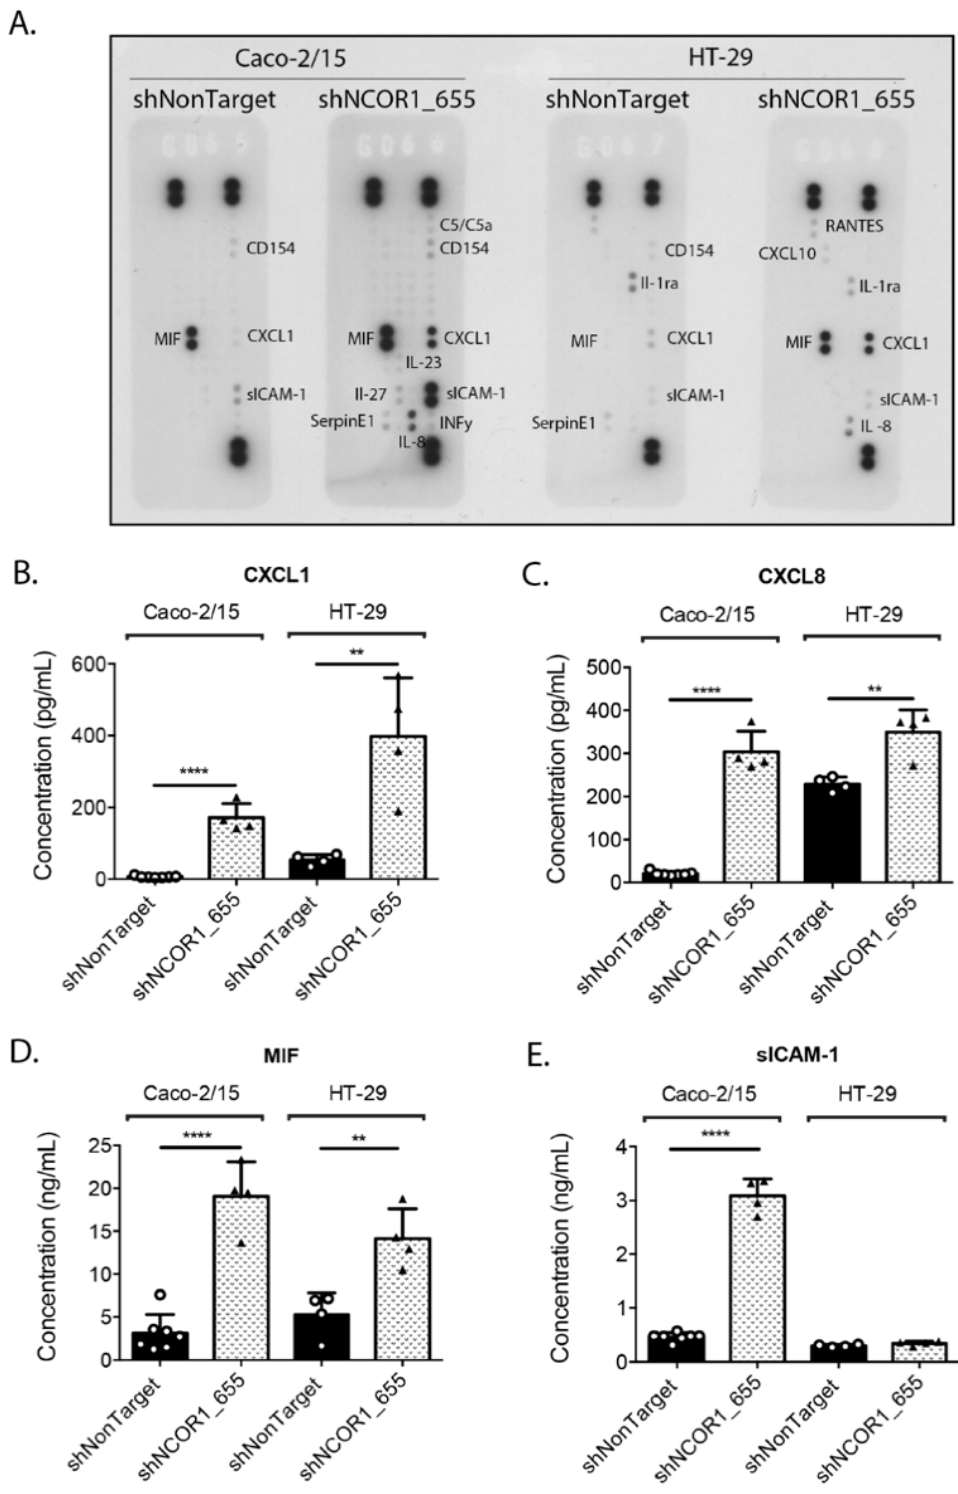
Figure 5. NCOR1 downregulation leads to a SASP in CRC cells. Caco-2/15 and HT-29 cells with integrated control shRNA (shNonTarget) or shNCOR1_655 were deprived of serum after 7 days of infection and the conditioned medium was then harvested after 48 h. Protein detection of cytokines and chemokines that had increased in SASP was visualized with the Human Cytokine Array Panel A kit ( A ). Specific ELISAs were used to quantify CXCL1 ( B ), CXCL8 ( C ), MIF ( D ), and sICAM-1 ( E ) ( n = 3; means ± SEM). Student’s t -tests were used to measure the significance of the results (** p < 0.01; **** p < 0.0001).